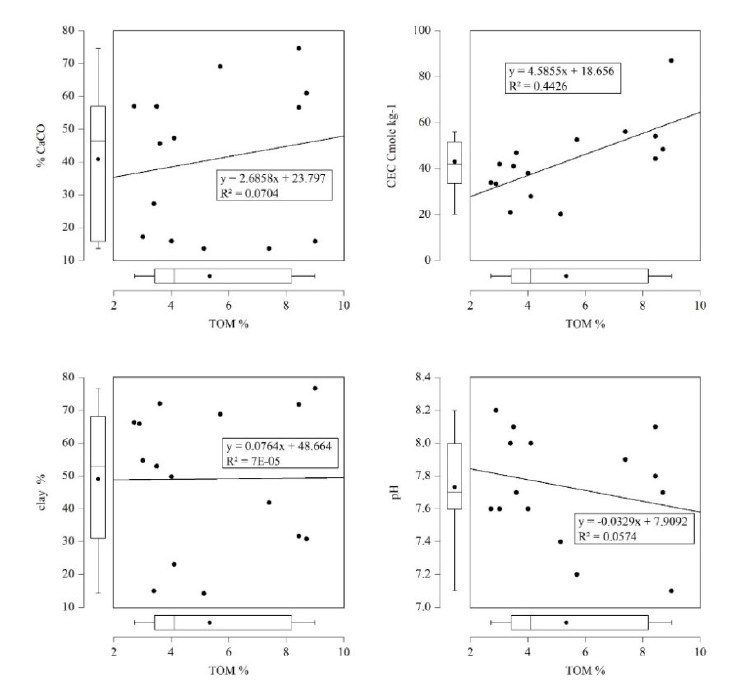
Figure 3. Scatter plot between some soil characteristics and TOM in forest